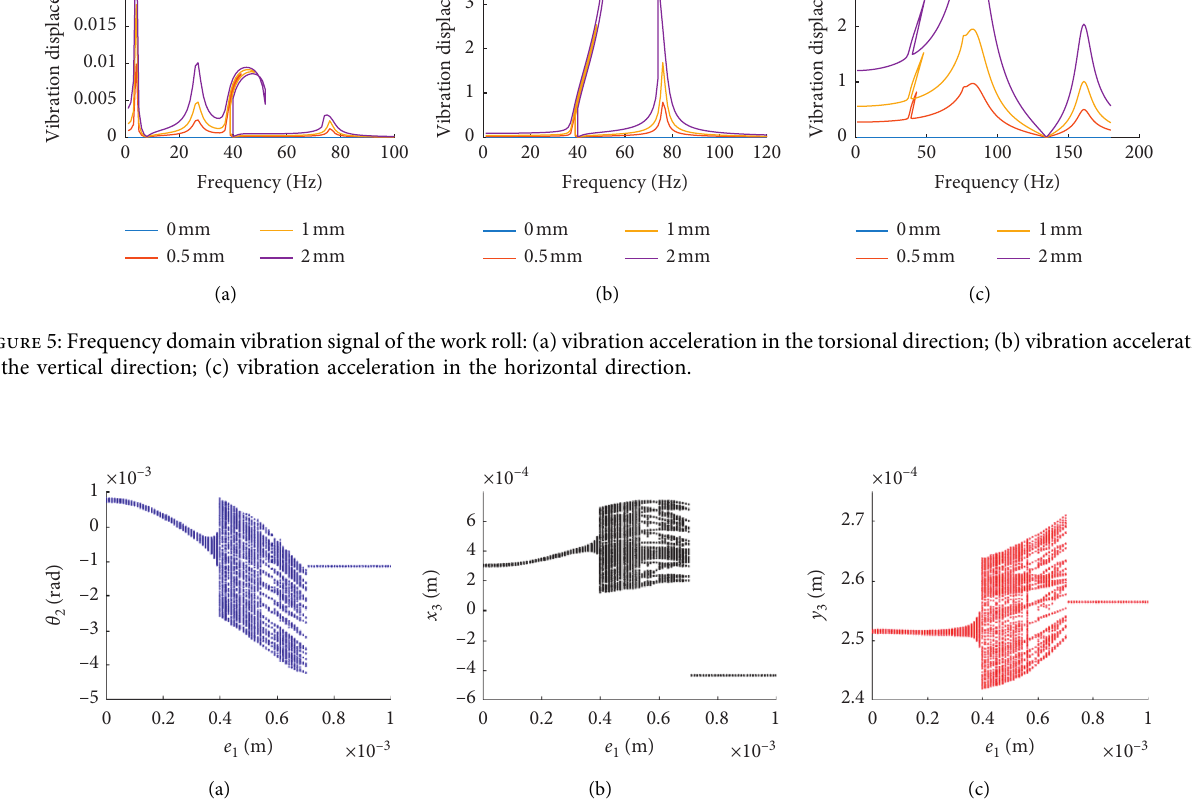
Figure 6: Bifurcation diagram under varying structure gap: (a) torsional direction; (b) vertical direction; (c) horizontal direction.